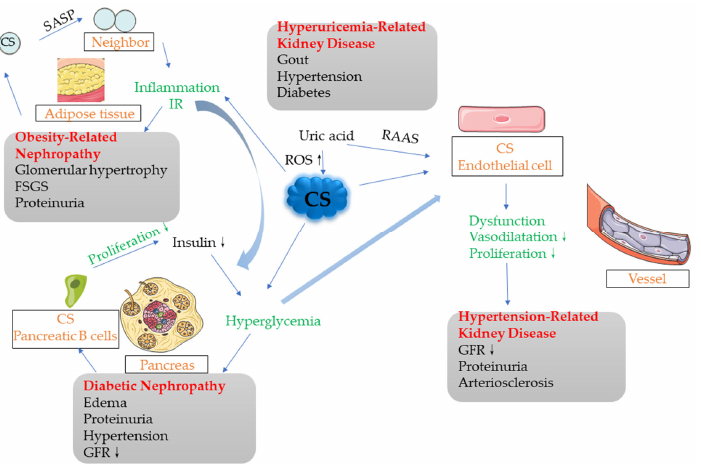
Figure 2. Potential associations among various metabolic-related nephropathy factors. There exist associations among multiple metabolic-related nephropathy factors, which may affect each other or simply occur simultaneously. The cells in adipose tissues generate cellular senescence and release SASP, which, in the form of paracrine signaling, affect the surrounding normal tissues and cells, gradually producing an inflammatory environment that promotes IR, leading to obesity-related nephropathy in severe cases. The middle part of this process also intersects with DN, where IR is an important factor in the development of DN. Islet B cells become old and their proliferation is blocked.